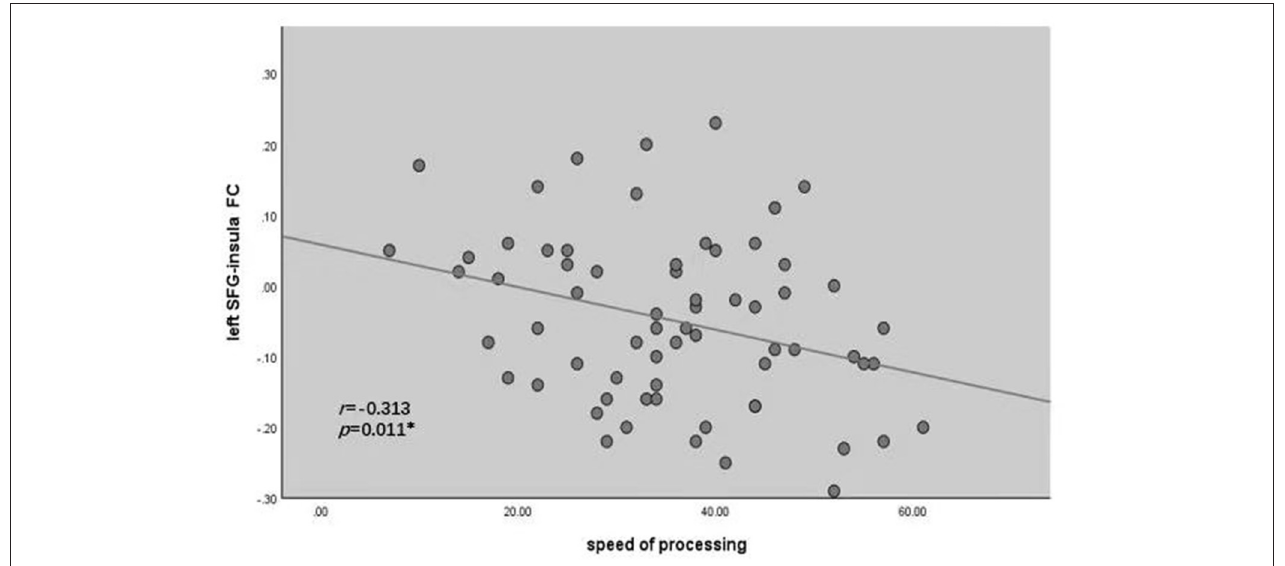
FIGURE 2 | Correlations between the FC of altered regions and cognitive assessments in youth-onset schizophrenia. Pearson’s correlation analysis in the patients showed that the decreased FC between left SFG and insula was negatively correlated with processing speed ( r = − 0.313, * P < 0.05). SFG, Superior Frontal Gyrus; FC, functional